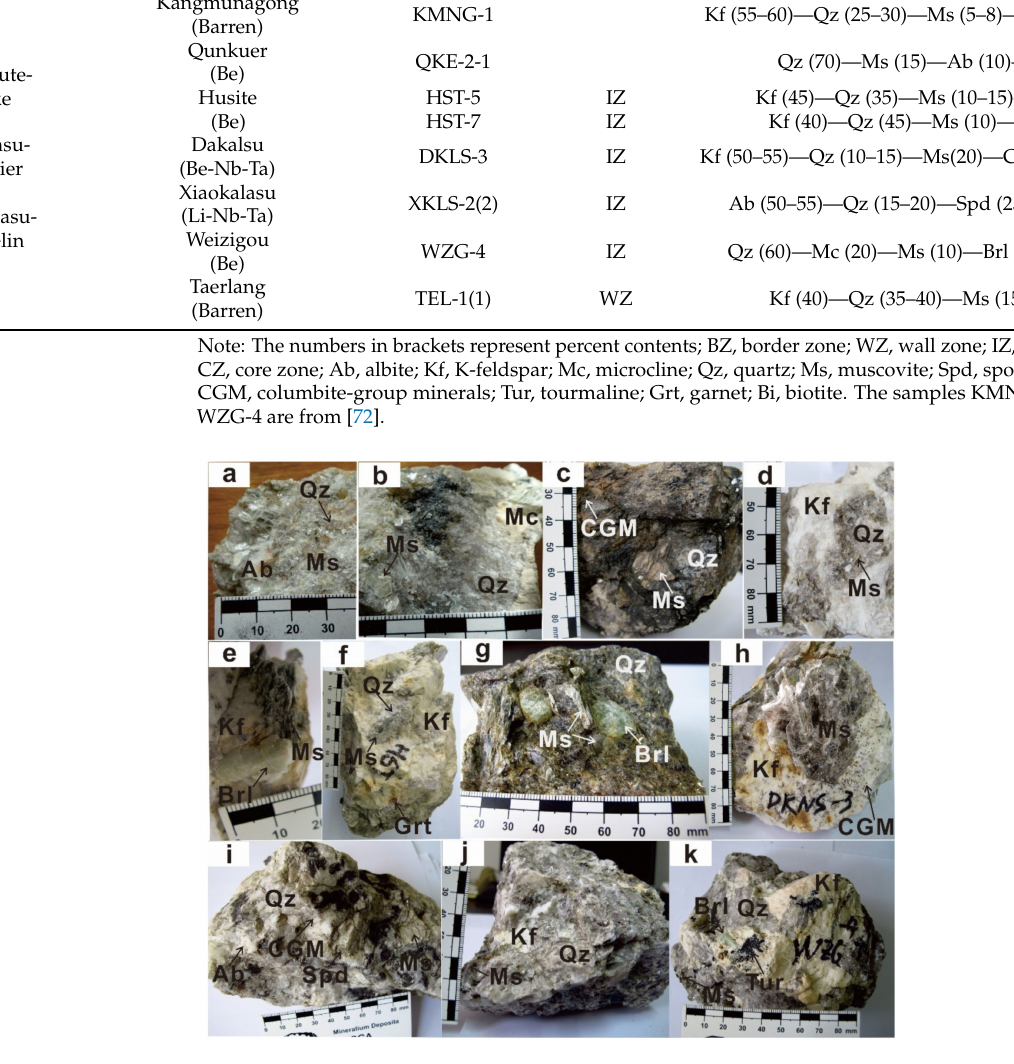
Figure 2. Photographs of samples ( a ) 12TLT-4, ( b ) 12TLT-7, ( c ) BC-2, ( d ) KMNG-1, ( e ) HST-5, ( f ) HST-7, ( g ) QKE-2-1, ( h ) DKLS-3, ( i ) XKLS-2(2), ( j ) TEL-1(1), ( k ) WZG-4. Ab, albite; Kf, K-feldspar; Qz, quartz; Ms, muscovite; Spd, spodumene; Brl, beryl; CGM, columbite-group minerals; Tur, tourmaline; Grt, garnet. Photos g and k are from